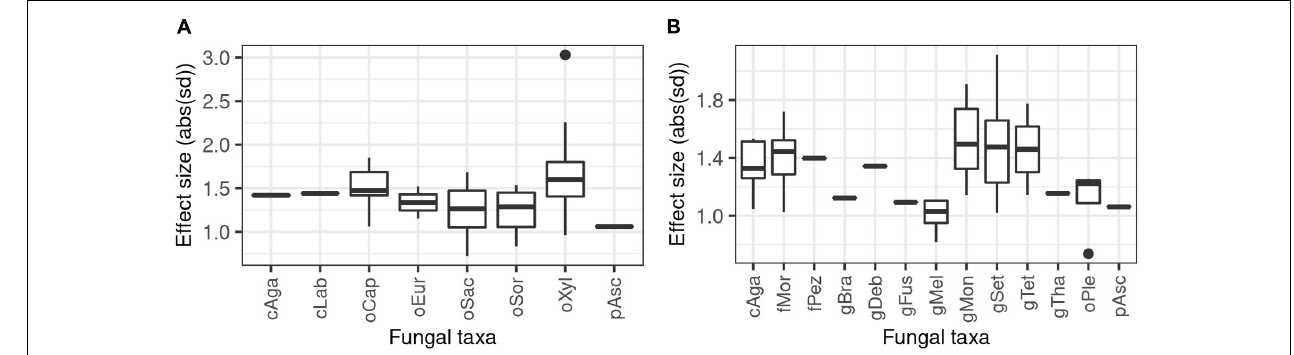
FIGURE 2 | Effect size comparison of various fungal taxa, obtained from statistically significant correlations between logratio-transformed fungal abundance (proportion) data and core chemical feature abundance data. Phenomena were considered significant at p < 0.05 after Benjamini–Hochberg adjustment of p -values for all statistical tests. Effect size is defined as the difference of the fungal abundance data between the first and fourth quartile of the chemical data, expressed as absolute value of standard deviations. Subplots: (A) phenomena at order level resolution; (B) phenomena at genus level resolution. cAga, class Agaricomycetes; cLab, class Laboulbeniomycetes; fMor, family Morosphaeriaceae; fPez, family Pezizaceae; gBra, genus Brachyphoris ; gDeb, genus Debaryomyces ; gFus, genus Fusarium ; gMel, genus Melanoleuca ; gMon, genus Monosporascus ; gSet, genus Setophoma ; gTet, genus Tetracladium ; gTha, genus Thanatephorus ; oCap, order Capnodiales; oEur, order Eurotiales; oPle, order Pleosporales; oSac, order Saccharomycetales; oSor, order Sordariales; oXyl, order Xylariales; pAsc, phylum Ascomycota.